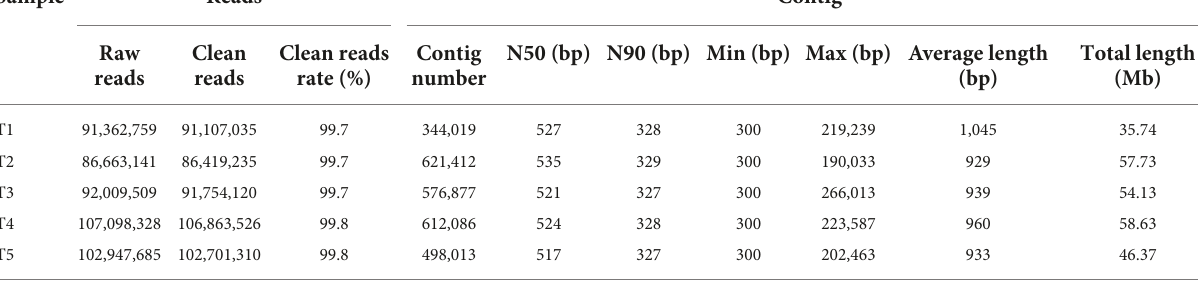
TABLE 1 Summary of de novo assembly results of the five time point metagenomic DNA samples from the composting substrate of oyster mushroom.